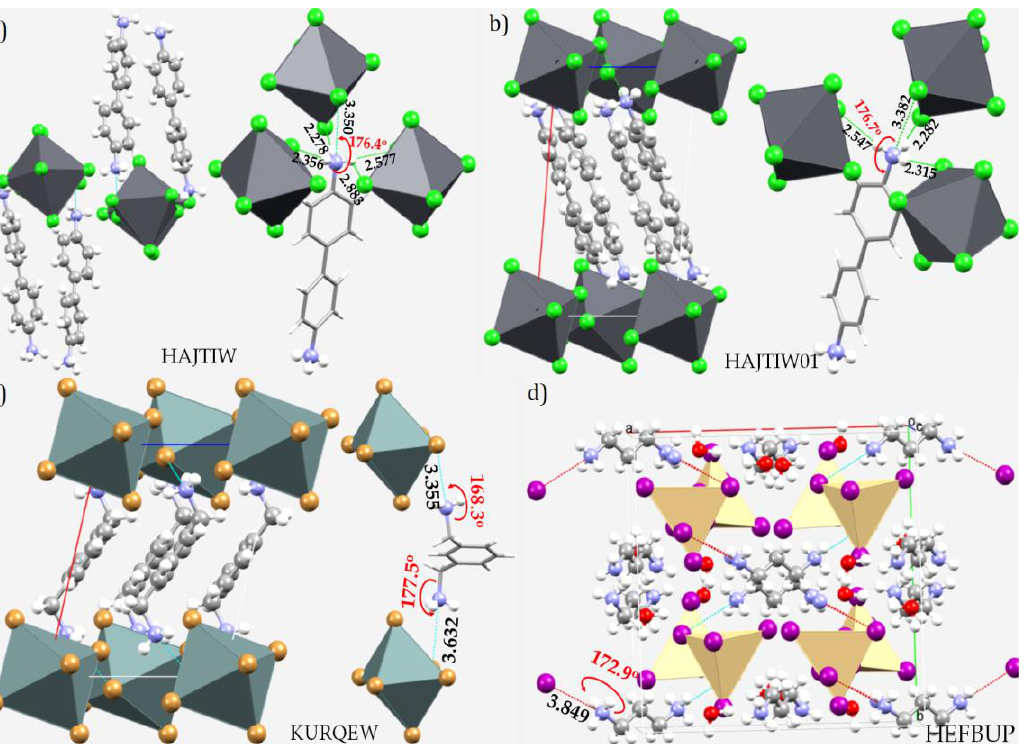
Figure 26. Ball-and-stick and polyhedral models of selected organic-inorganic hybrid metal halide perovskite and non-perovskite 0D structures. ( a ) bis(1,4-phenylenediammonium) hexachloro- lead(II) (C 12 H 14 N 22+ ) 2 (PbCl 64 − ) [167]; ( b ) the same compound the structure of which was reported by a different group [168]; ( c ) bis[(1,3-phenylene)dimethanaminium] hexabromo-tin (C 8 H 14 N 22+ ) 2 (SnBr 64 − ) [169]; ( d ) 1,3-propanediammonium tetraiodo-cadmium(II) dihydrate (C 3 H 12 N 22+ )(CdI 42 − )·2(H 2 O) [170]. Intermolecular contacts between bonded atomic basins are illus- trated as dotted lines in cyan and hanging contacts in red. Selected bond distances and bond angles associated with the nitrogen-centered pnictogen bonds are in Å and degrees, respectively.